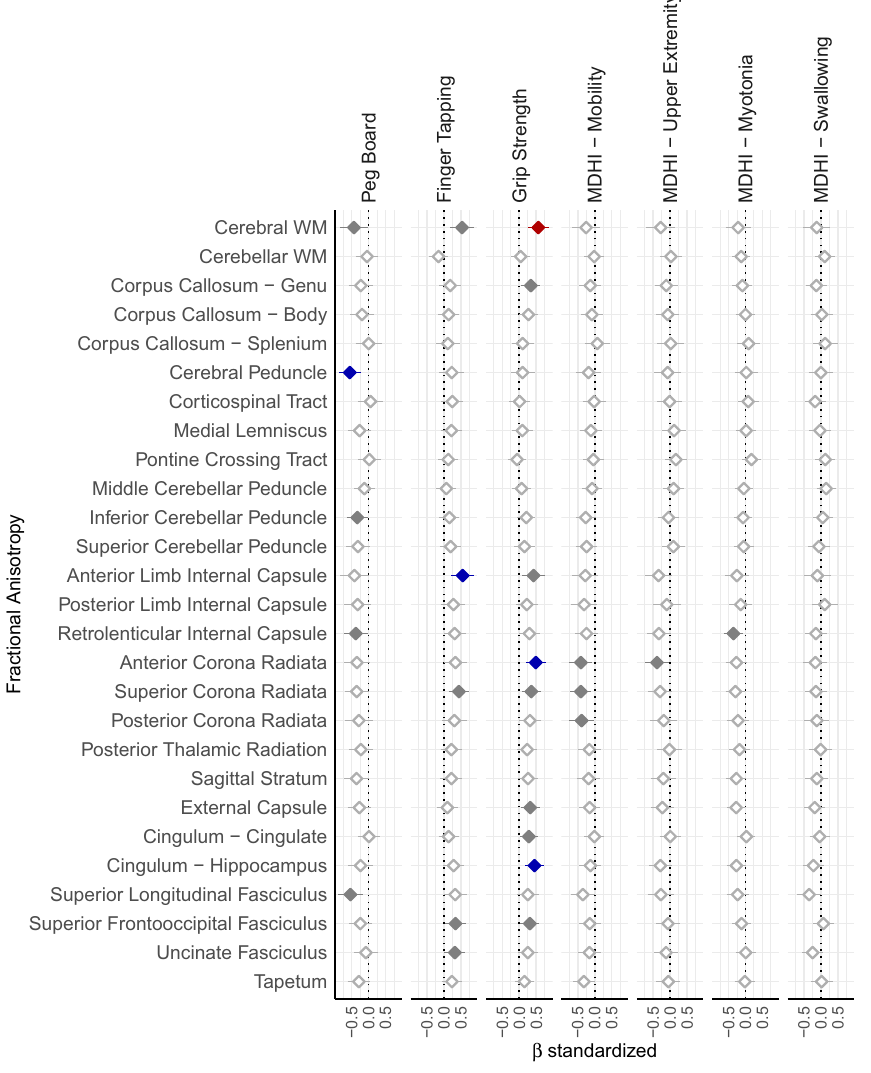
Figure 4. Fractional anisotropy predicting motor outcomes. The figure lists standardized betas listed on the x-axis for the association between regional FA (y-axis) and motor outcomes (top facets). Significant associations are marked by color, where red indicates VOIs where FDR-corrected p < 0.05, blue indicates FDR-corrected p < 0.1, gray indicates uncorrected p < 0.05, and white indicates uncorrected p > 0.05. Error bars represent the 95%. Data were plotted using R (version 3.5.0, https ://www.r-proje ct.org/) 25